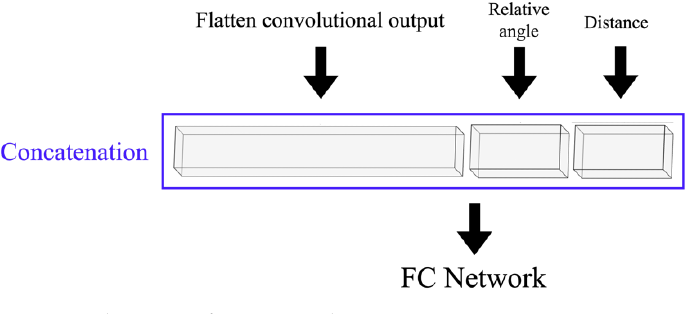
Figure 3. The input of FC Network.